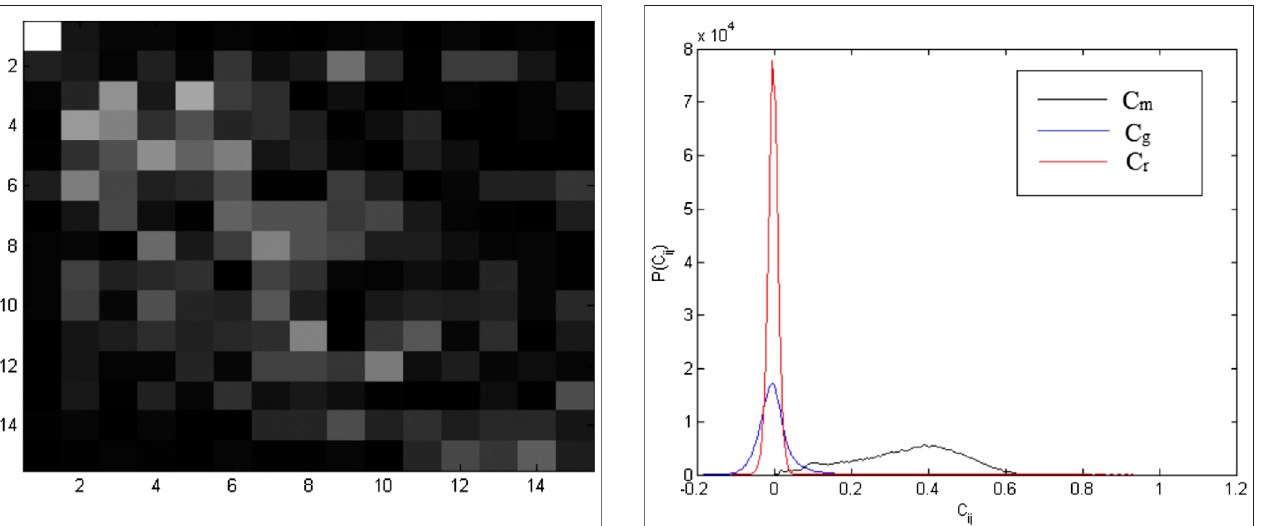
FIGURE 8 | Stability of the eigenvectors from the largest eigenvectors ( u 1 )to ( u 15 ) of C intheS&P500dailystockpricedatafortheperiodofJanuary 1, 2007 until October 28, 2016. White blocks indicate stable areas, and black blocks indicate unstable regions.